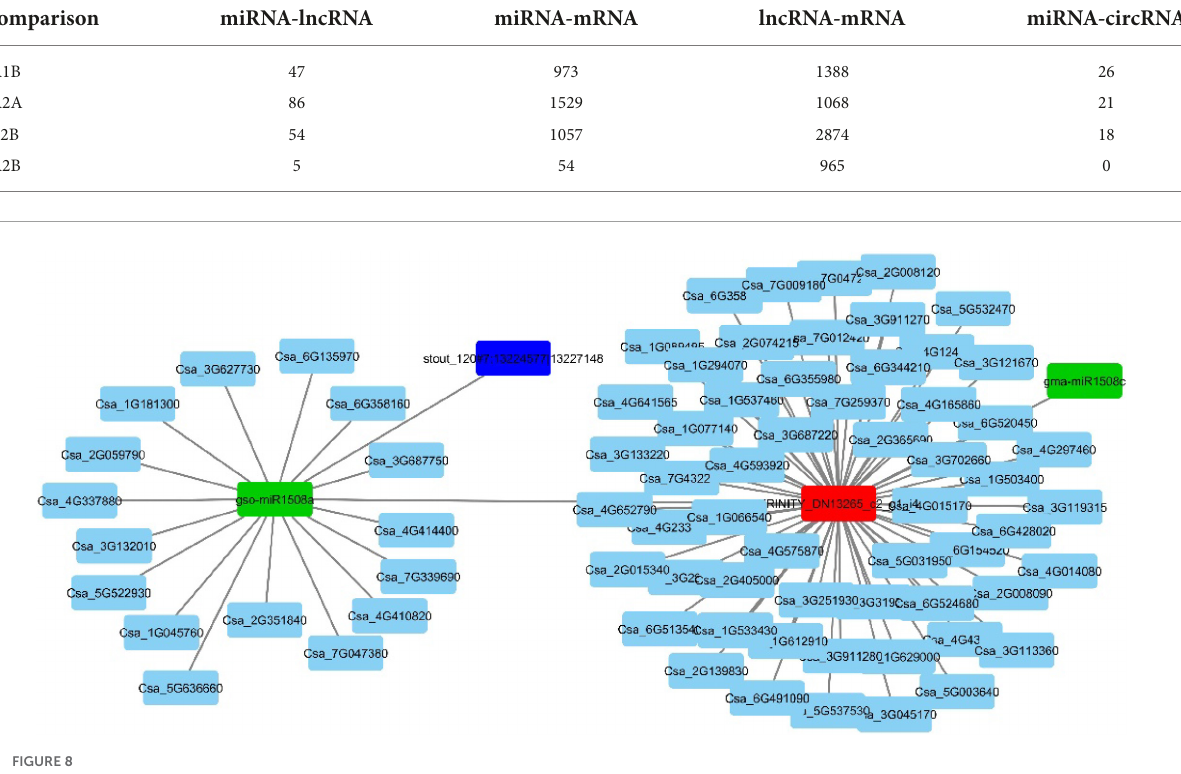
FIGURE8 ceRNA network of the validated